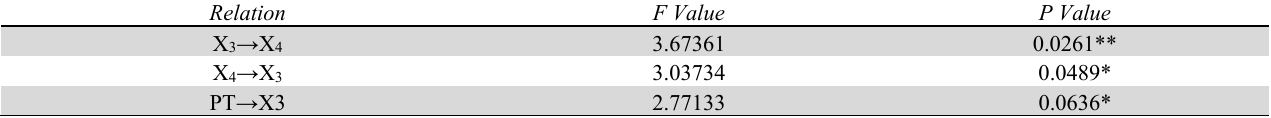
Table of Granger causal relation test of explanatory variables and explained variables of hot rolled coils Relation F Value P